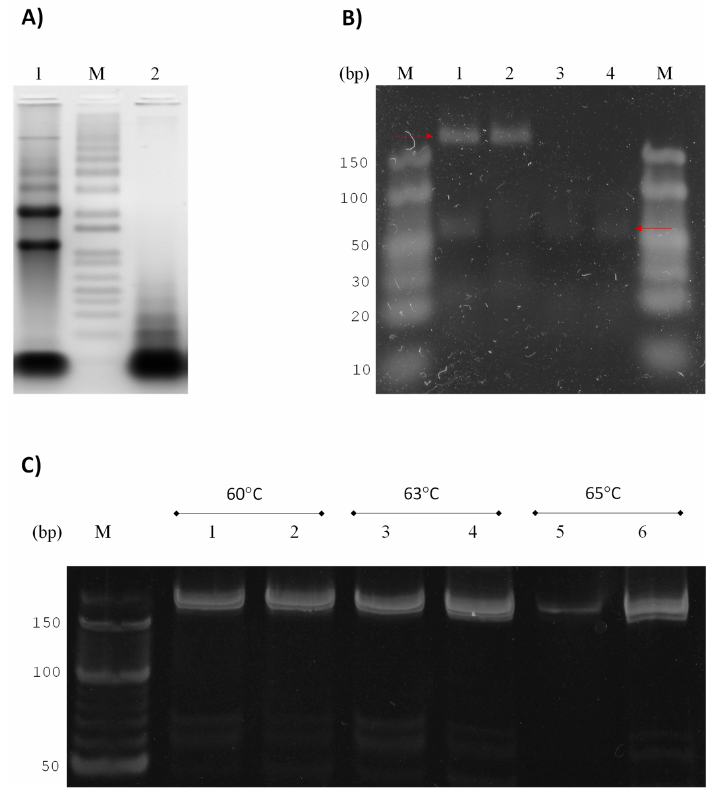
Figure 2. Identification of PCR ‐ amplified fragments as GlsR17 and miR2 from G . lamblia . ( A ) Total RNA (lane 1) and small RNA (lane 3) extracted from G . lamblia trophozoites (see Materials and Methods) run on a 2% agarose gel; the size marker (M) was 1 kb (lane 2) (O’GeneRuler 1 kb DNA Ladder, Thermo Scientific); ( B ) agarose gels (3%) with the result of the amplification stem ‐ loop RT ‐ PCR analysis for GlsR17 and miR2 (lanes 1–4), respectively, using total RNA (lanes 1 and 3) or small RNA (lanes 2 and 4) as a template. The expected size for the GlsR17 amplified fragment was 178 bp, and for the miR2 fragment 61 bp, which is in accordance with the size of the bands appearing in the gels; ( C ) GlsR17 amplification from a temperature gradient by PCR and run on a 16% polyacrylamide gel. Products obtained from total RNA (lanes 1, 3 and 5) and small RNAs (lanes 2, 4 and 6). To determine the size of the fragments corresponding to the small RNAs the marker (M) O’RangeRuler 10 bp DNA Ladder (Thermo Scientific) was